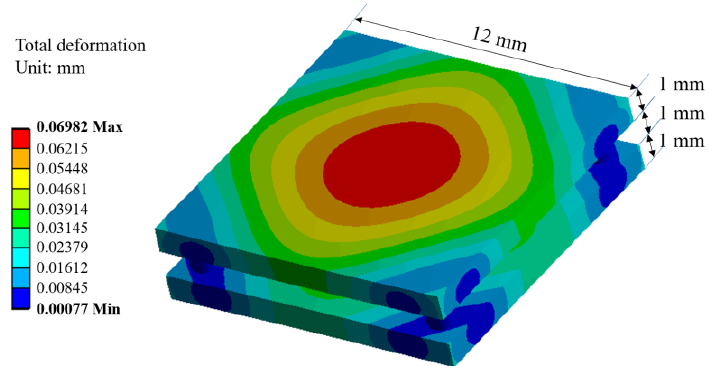
Figure 6. Total deformation in a VIP element (3-D).